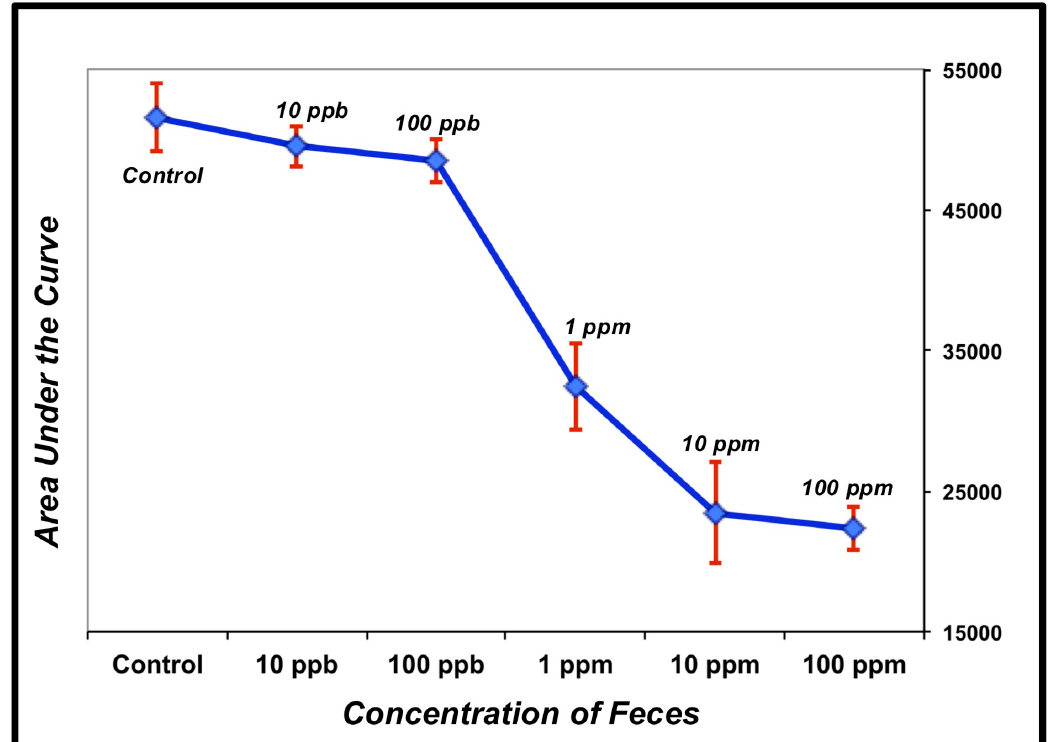
Figure 3. Detecting fecal contamination of water. Data were obtained using the plate-based biosensor with rAgamOBP1 at 1 µ M as the detector element. Data were collected using a spectrophotometer. Control samples contain only water. The areas under each curve were plotted on a semi-logarithmic scale in order to evaluate the linearity of the biosensor’s response. The linear range of detection ranges from 10 ppm to 100 ppb. The red bars are STDEV plotted with Excel and the raw data are shown in Appendix A Table